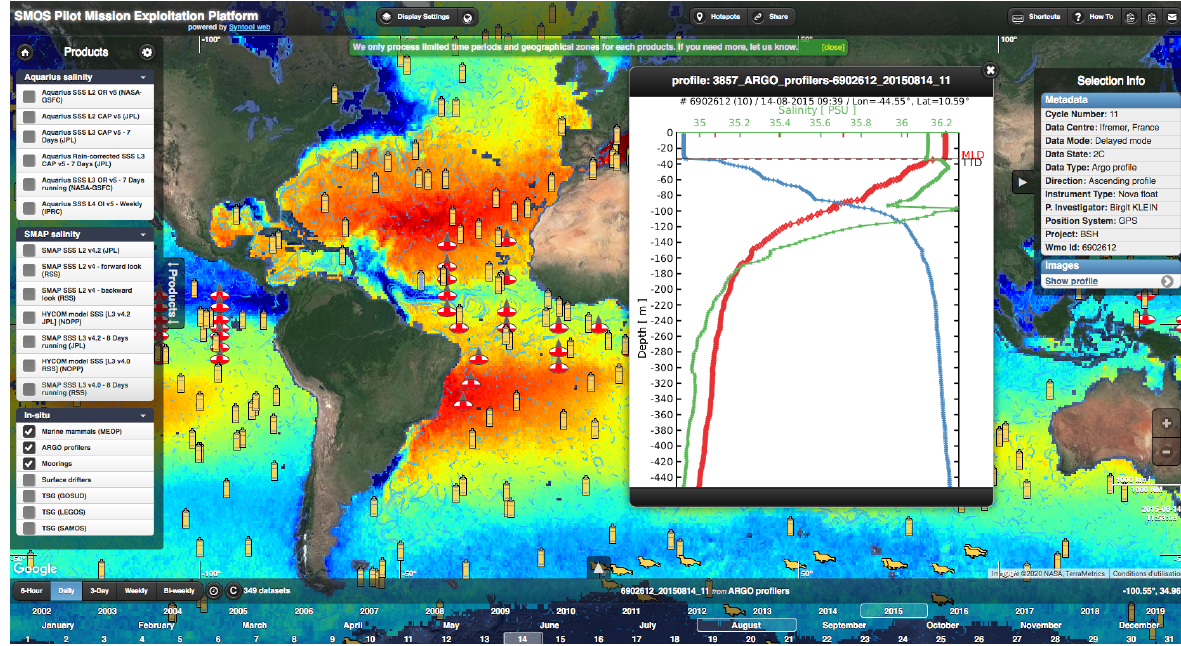
Figure 14. Illustration of Syntool data portal interface: The selection of products to be displayed is controlled by the left “Products” menu. The date and time selection is controlled by the lower banner (timeline). The mouse scroll controls zoom levels while on the map and time while on the timeline. Dates when selected products are available appear in white, or grey otherwise. When activating the collocation trigger, dates when all selected products are available within the time range and the visible map area appear in